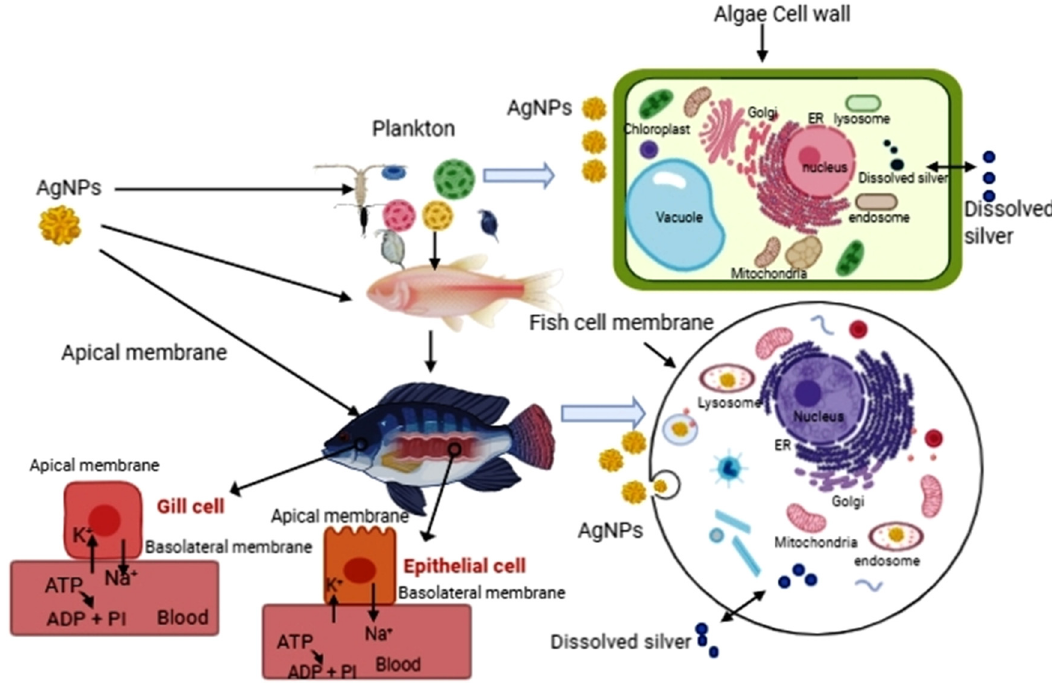
Figure 5: The e ff ect of AgNPs ’ dissolutions on aquatic